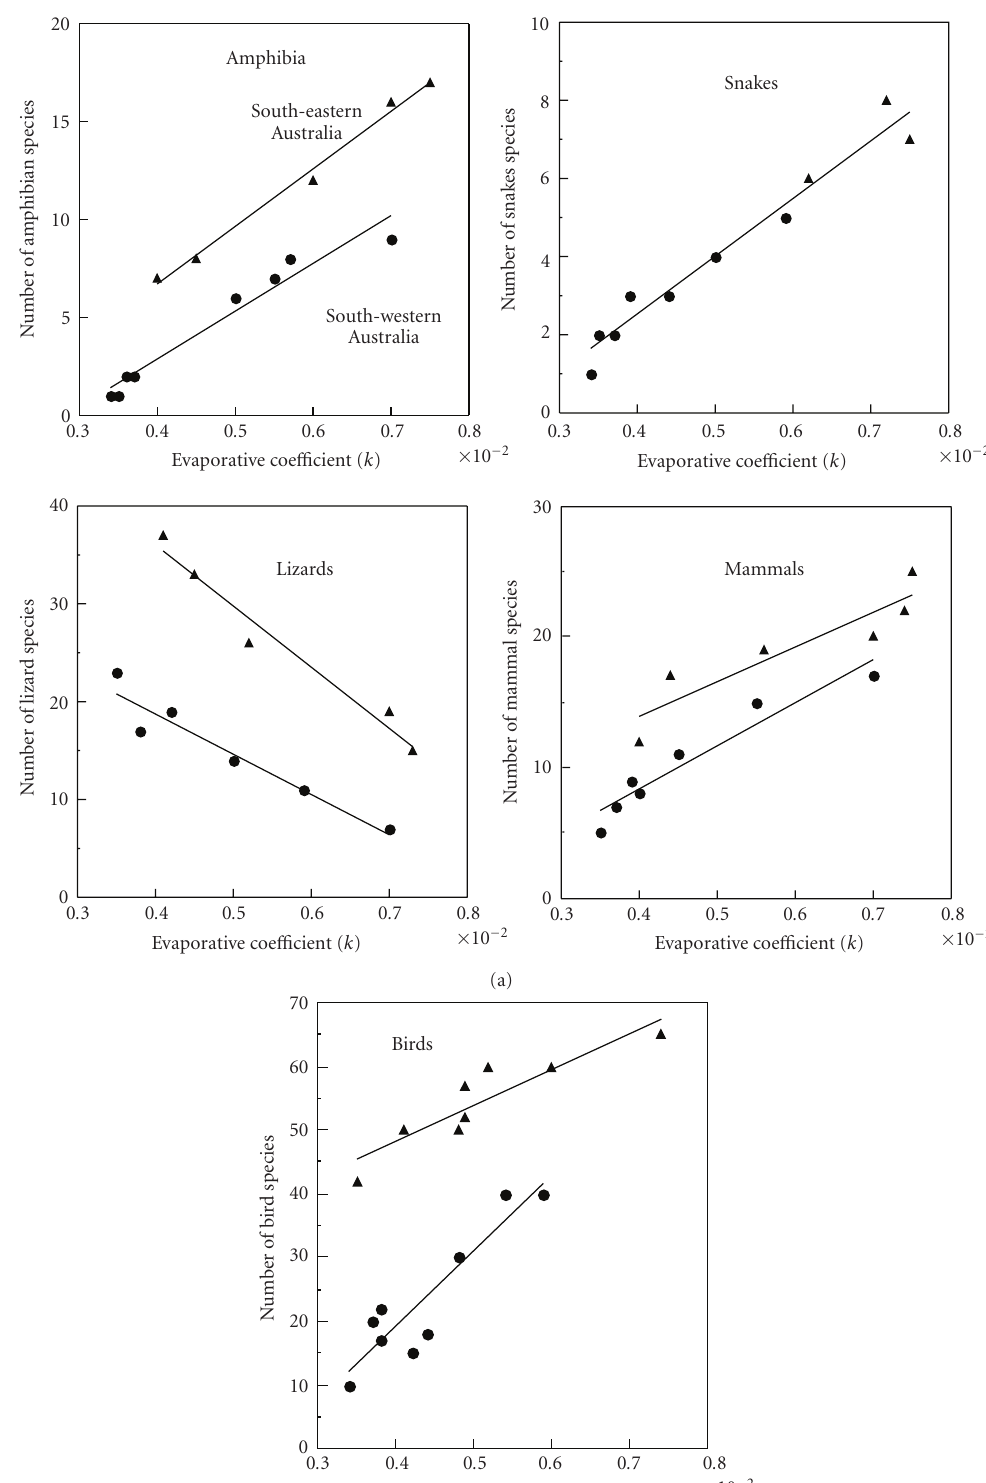
Figure 1: (a) Alpha diversity of amphibians, elapid snakes, lizards, and small mammals resident in plant communities in south-western ( o ) and south-eastern Australia ( (cid:2) ), plotted along the climatic gradient from the semiarid (Evaporative Coe ffi cient, k = 0 . 35 − 0 . 45 × 10 − 2 ) to the humid ( k = 0 . 55 − 0 . 75 × 10 − 2 ) climatic zones (after [15, 16]). (b) Alpha diversity of birds resident in plant communities in south-western ( o ) and south-eastern Australia ( (cid:2) ), plotted along the climatic gradient from the semiarid (Evaporative Coe ffi cient, k = 0 . 35 − 0 . 45 × 10 − 2 ) to the humid ( k = 0 . 55 − 0 . 75 × 10 − 2 ) climatic zones (after [15, 16]). (Data for south-western Australia are summarized by Specht in [17] and revised by Professor Martin Cody,